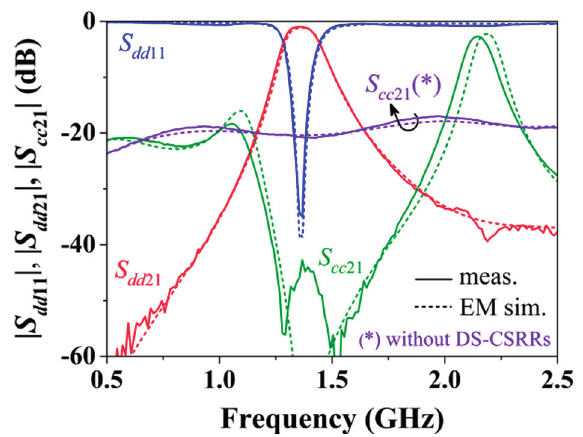
Figure 20. Simulated and measured differential-mode return loss | S dd 11 | and insertion loss | S dd 21 |, and common-mode insertion loss | S cc 21 | for the structure of Figure 19b with and without the presence of the DS-CSRRs. From [27]; reprinted with permission from IEEE